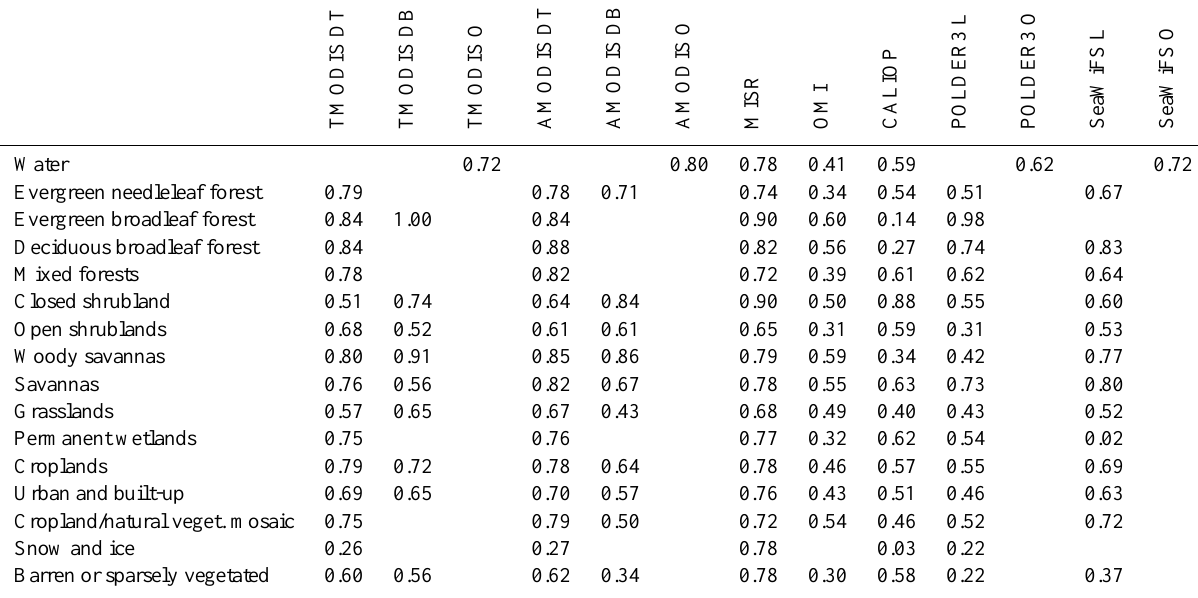
Table 4. Linear fit correlation coefficient ( R 2 ) between the collocated spaceborne and ground-based observations of AOD estimated at the stations that coincide with different IGBP land cover types. Empty cells indicate no collocated data available from a specific sensor over a specific land cover type. No AERONET stations are available at the areas occupied by deciduous needleleaf forest. The statistics were calculated based on the data that were pre-filtered by QA and screened of outliers as described in Sects. 4 and 5. A graphical representation of this table is in Fig. 13. Please see the Supplement for a breakdown of the listed statistics based on the nominal boreal seasons.